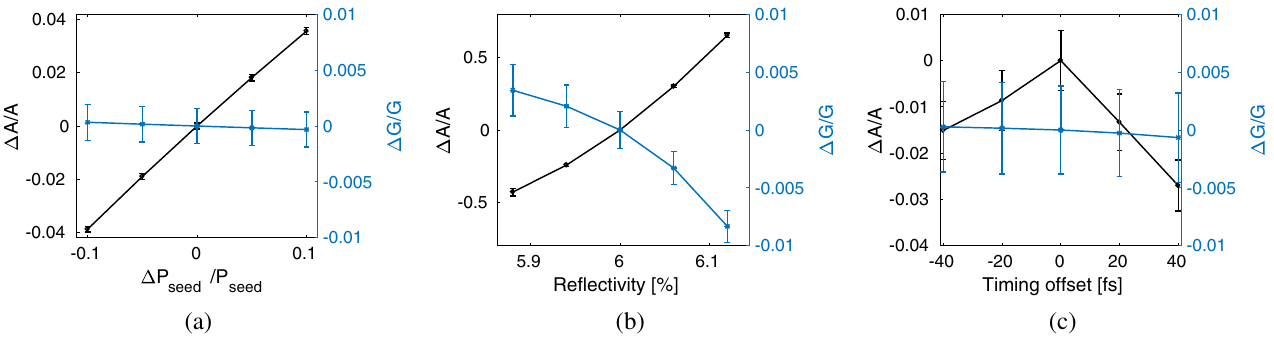
FIG. 6. Overview of the stability study. In (a) the effect of seed laser peak power, P , fluctuation up to (cid:2) 10% is shown, in (b) the seed reflectivity tolerances for up to (cid:2) 2% and (c) the effect of timing offset between the external seed laser pulse and the electron beam for up to (cid:2) 40 fs. In all cases we show the effect on the relative normalized energy modulation Δ A=A , achieved at the steady state in the oscillator (passes between 30 and 100), and on the right axis, the effect on the relative power gain, Δ G=G as an average over the same passes. The error bars indicate the standard error on the mean values calculated at the steady